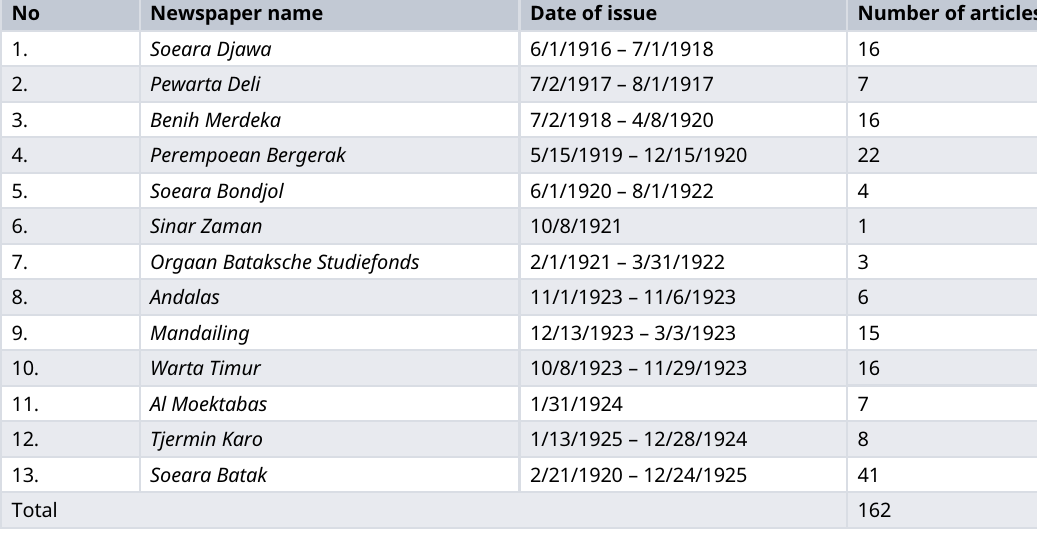
Table 2. Indigenous newspapers in North Sumatra (1916-1925) that featuring news about Indonesia as a Dutch colony.